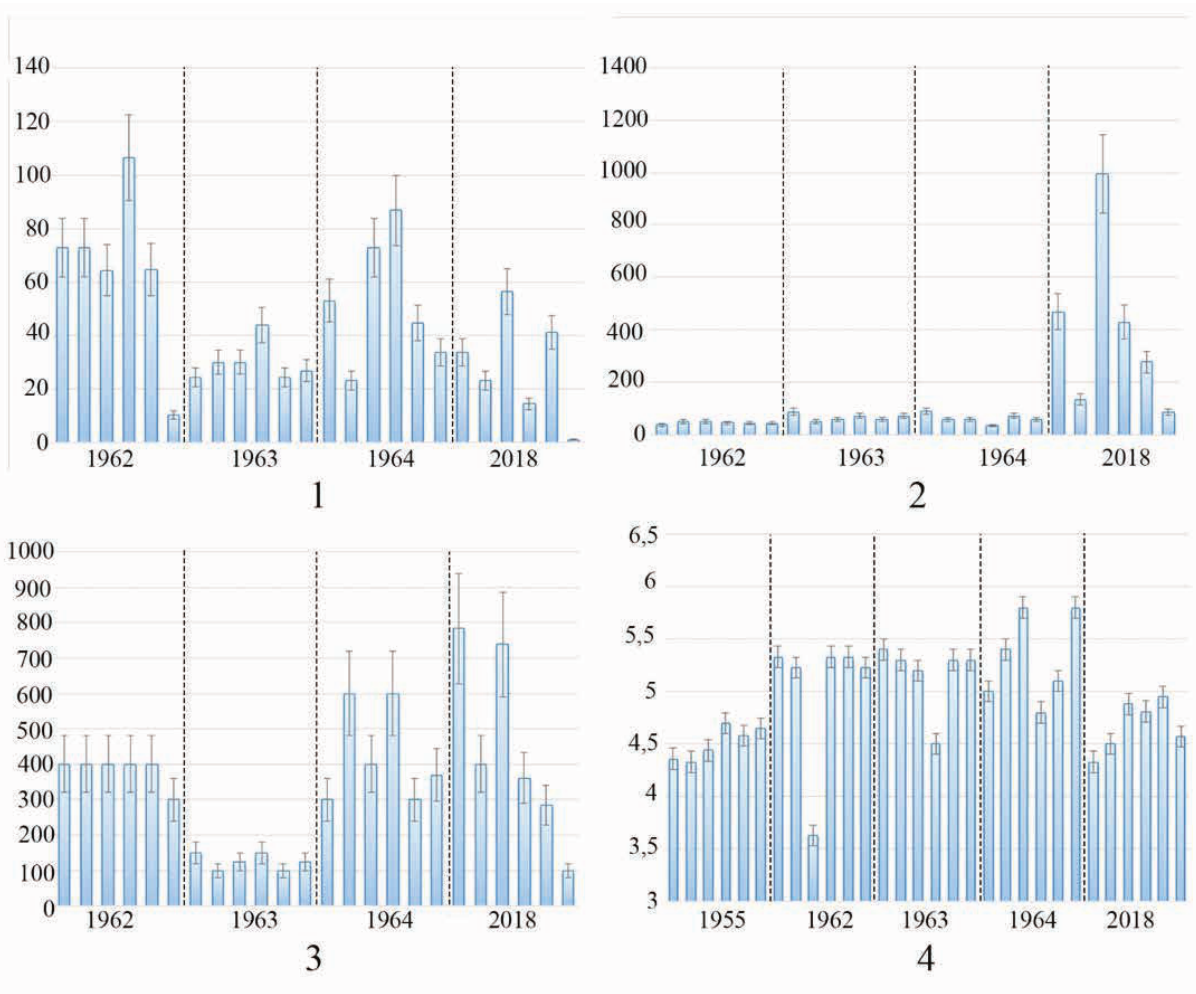
O; 3, P2O5; 4, pH 2